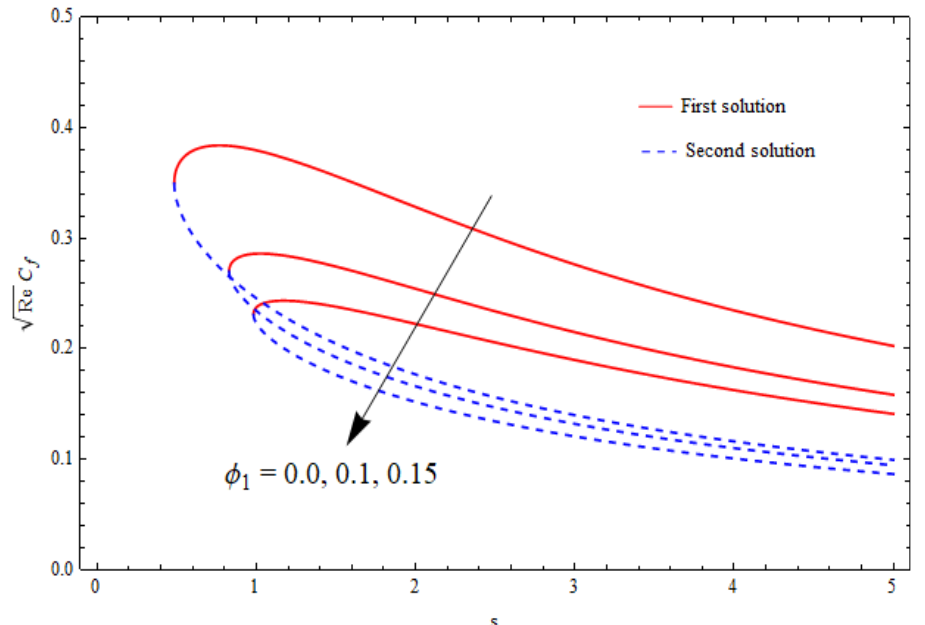
Figure 13. Variation in the skin-friction coefficient k 1 = 1 = γ , δ = − 1, ϕ 2 = 0.1.